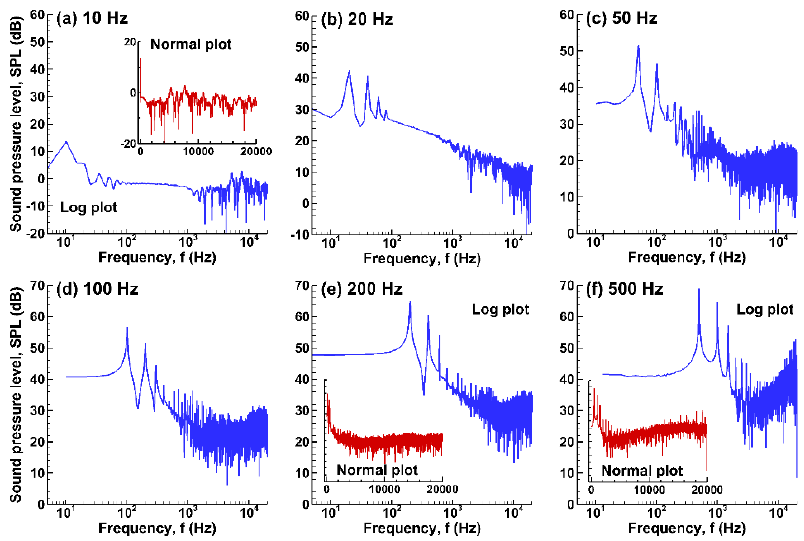
Figure 11. Sound pressure level (SPL) of the pressure signals at different glottal vibration frequencies: ( a ) 10 Hz, ( b ) 20 Hz, ( c ) 50 Hz, ( d ) 100 Hz, ( e ) 200 Hz, and ( f ) 500 Hz.